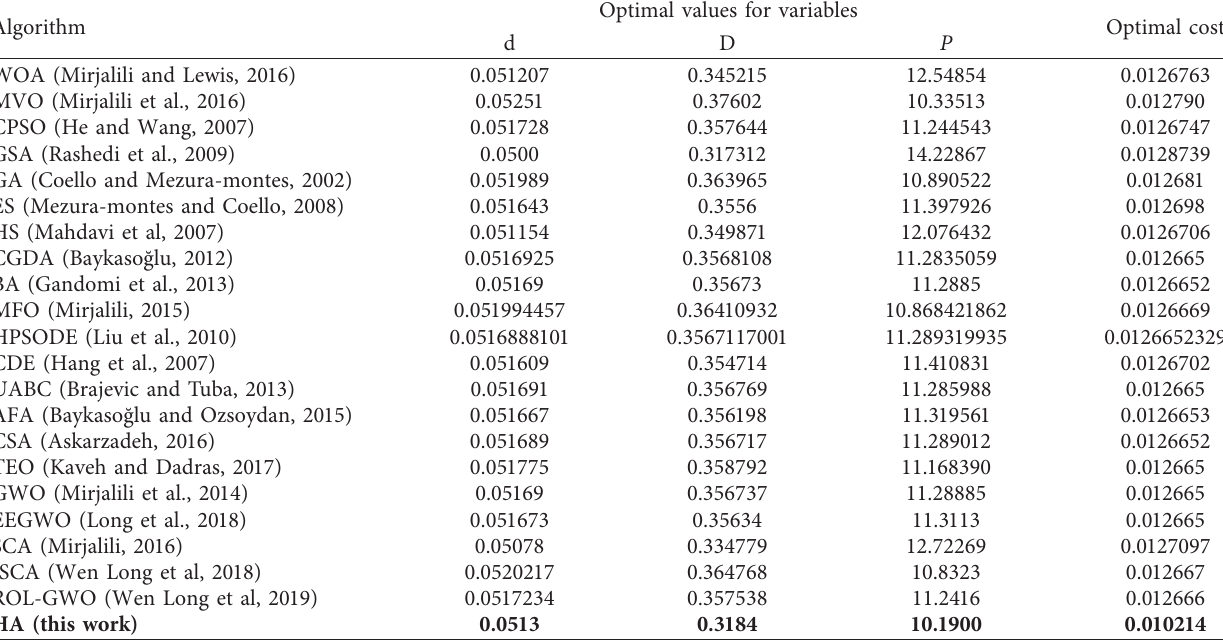
Table 4: The experimental results of HA and other algorithms for tension/compression spring design problem. Algorithm